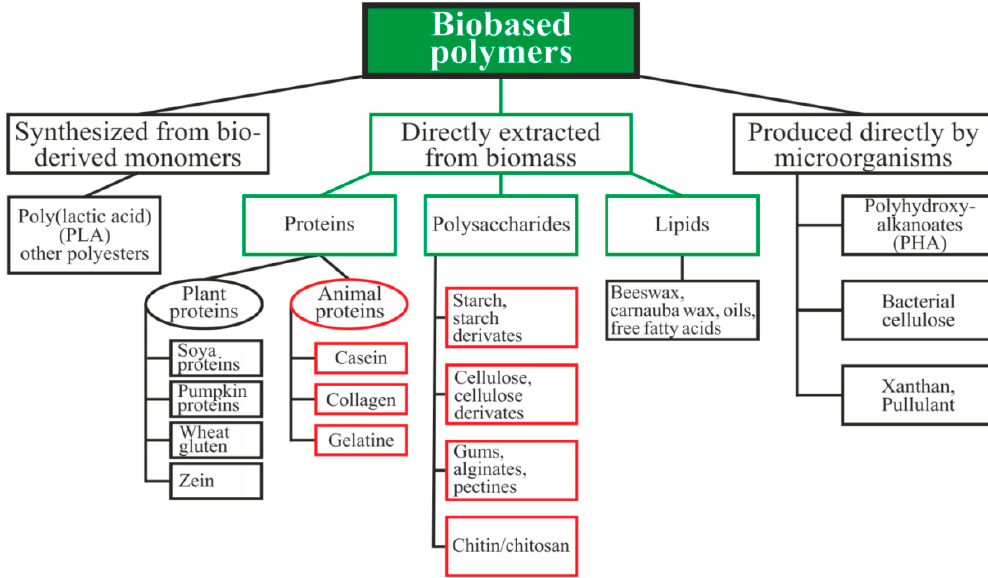
Figure 1. Schematic classification of biopolymer types [15,18,19]. Reproduced with permission from Popovi ć , S.Z. et al., Biopolymers for Food Design; published by Elsevier Inc., 2018.